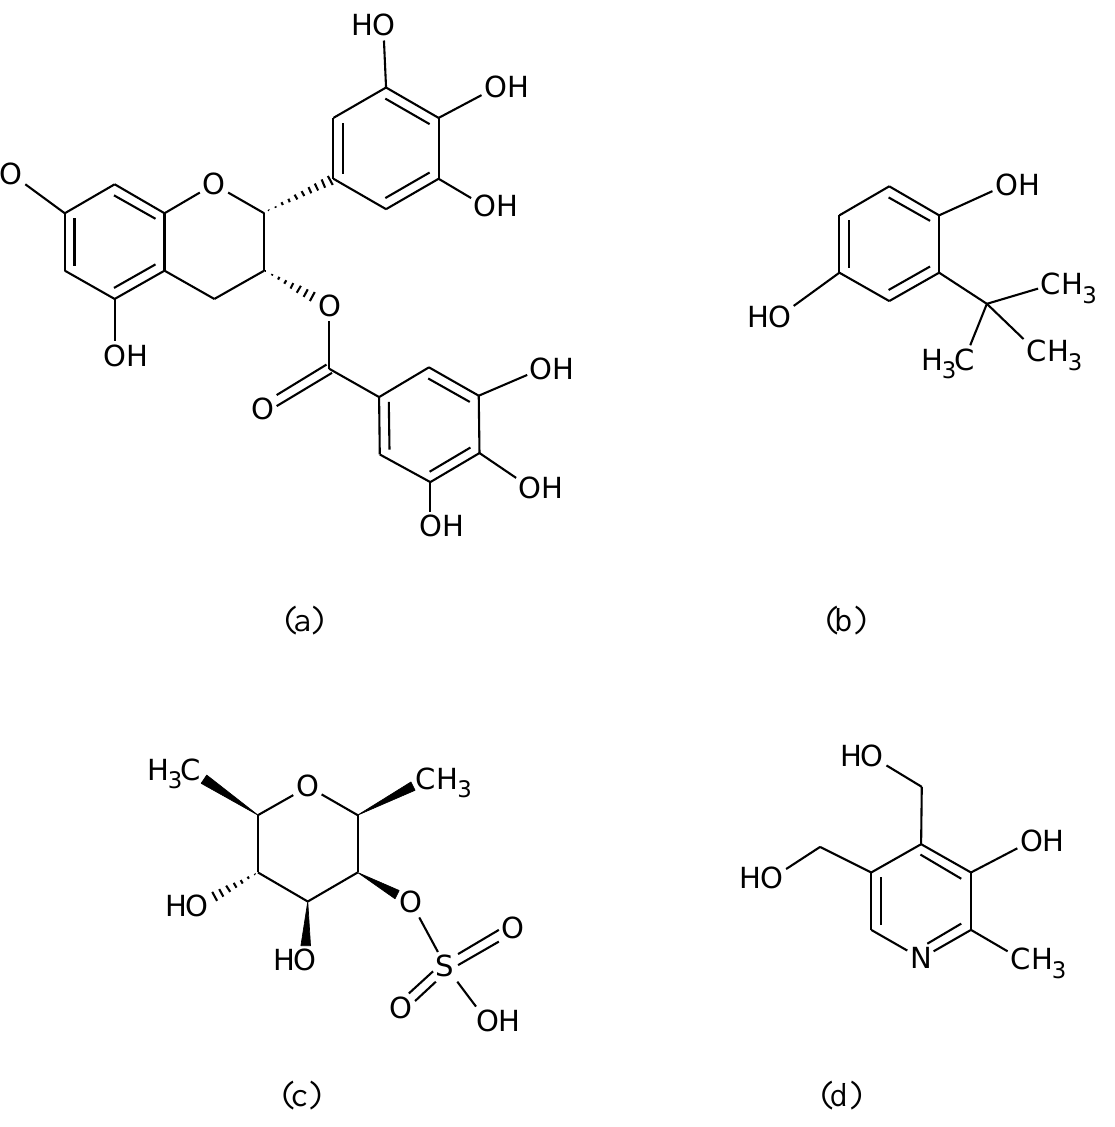
Figure 9. Chemical formula of ( a ) Epigallocatechin gallate, ( b ) Tert-butylhydroquinone (tBHQ), ( c ) Fucoidan, ( d ) Pyridoxine.